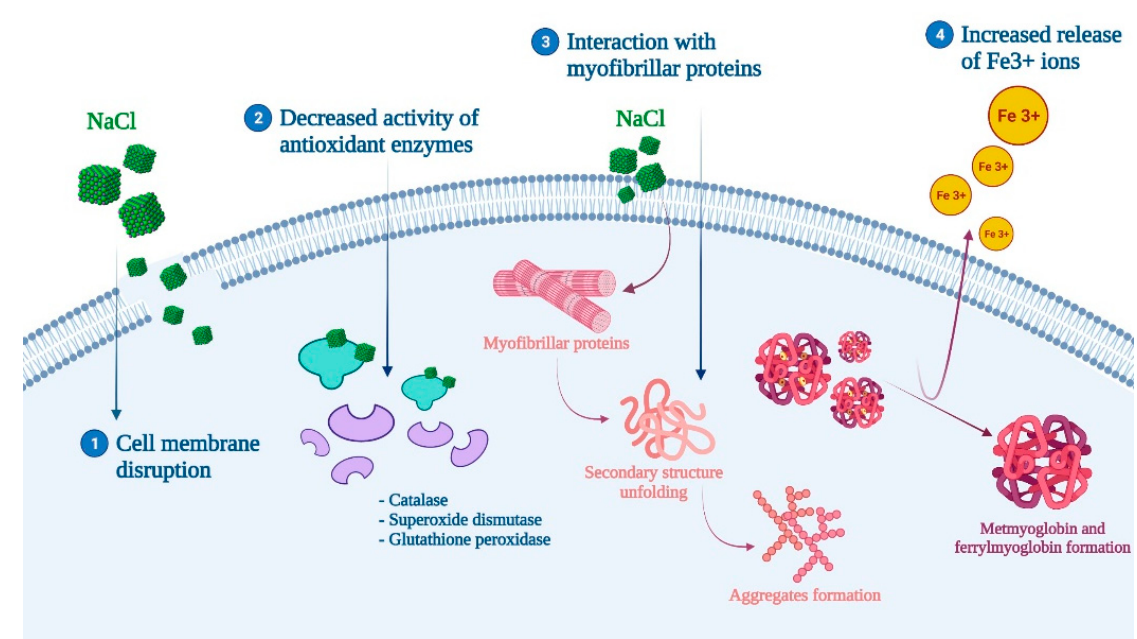
Figure 3. Proposed mechanism of action for salt (NaCl) and protein oxidation.